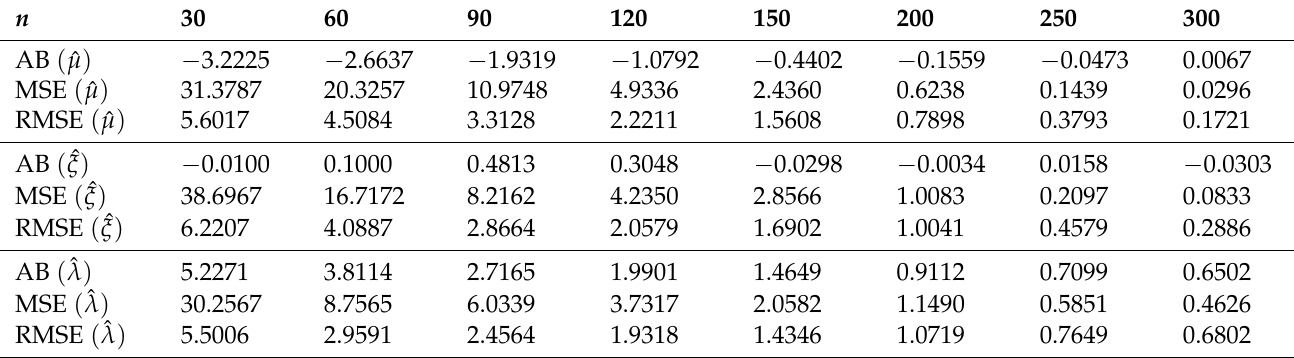
Table 2. Numerical outcomes of AB and MSE values of the NIGT-II model for µ = 6.2, ξ = 4.7, λ = 2.5.